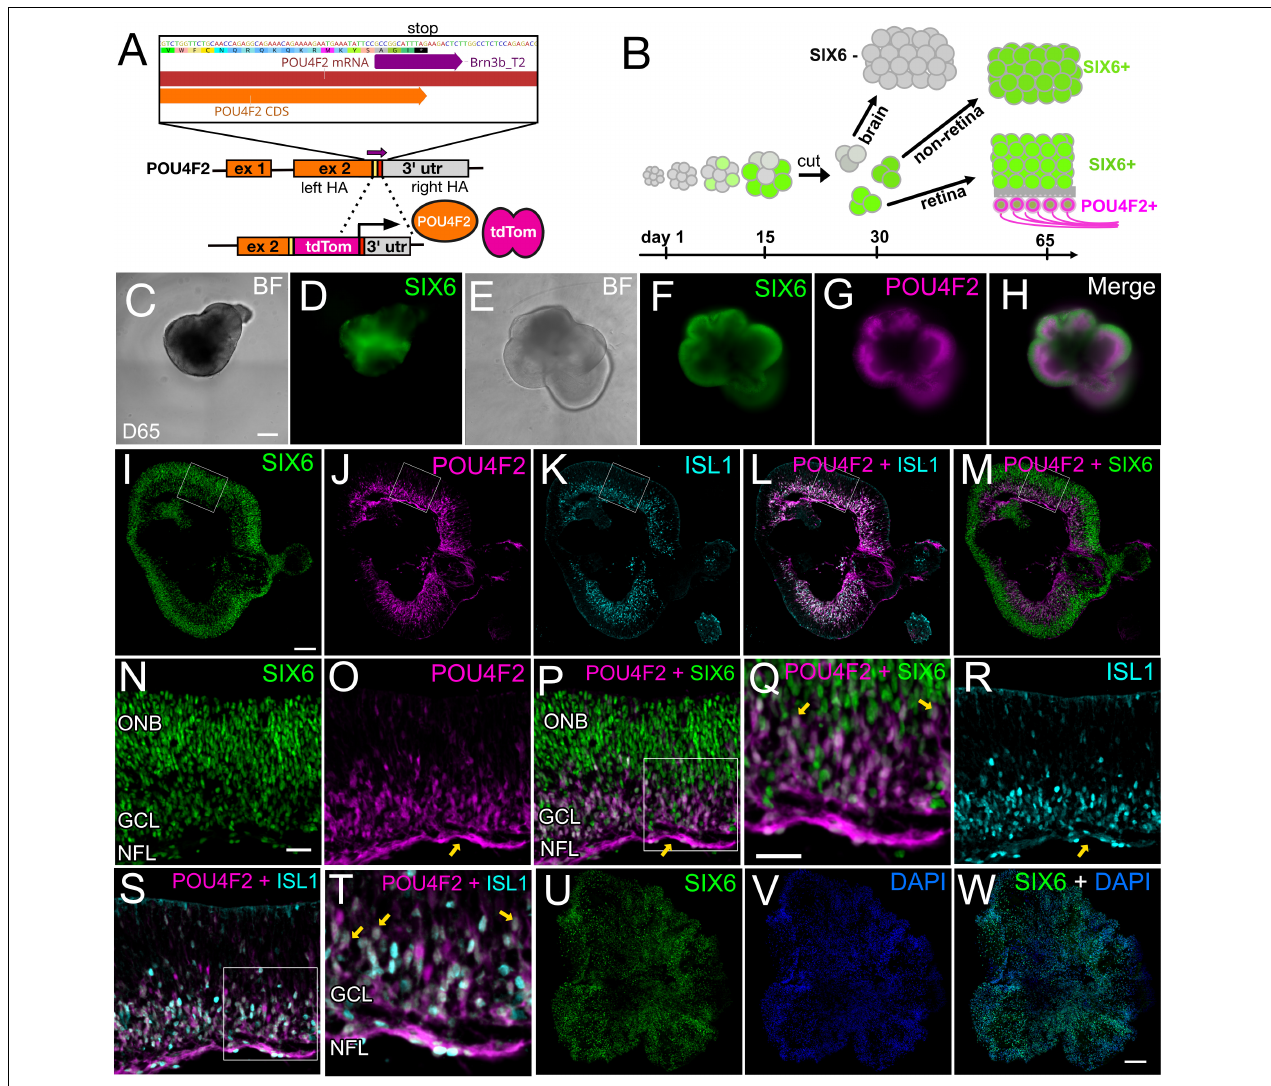
FIGURE 6 | A SIX6-GFP and POU4F2-tdTomato dual color reporter for live-cell imaging of bona fide retinal organoids. (A) Diagram showing the targeting of a p2A-tdTomato cassette into the endogenous POU4F2 locus. (B) Workflow differentiating different tissues and identification of retina or brain region based on fluorescence. (C,D) Live cell bright field and fluorescence imaging of a day 65 organoids expressing SIX6-GFP, but lacking POU4F2-tdTomato. (E) Live cell bright field image of retinas at the same age expressing (F) SIX6GFP, (G) POU4F2, and (H) a SIX6/POU4F2 merged image. Frozen cryosections of POU4F2 + organoids with images of (I) SIX6-GFP, (J) POU4F2-tdTomato, (K) ISL1, (L) POU4F2/ISL1, and (M) POU4F2/SIX6. High magnification images of (N) SIX6 label the entire retina with the strongest signals in the outer neuroblast (ONB) layer. (O) POU4F2 is localized to the inner aspect of the retina near the nerve fiber layer (NFL)